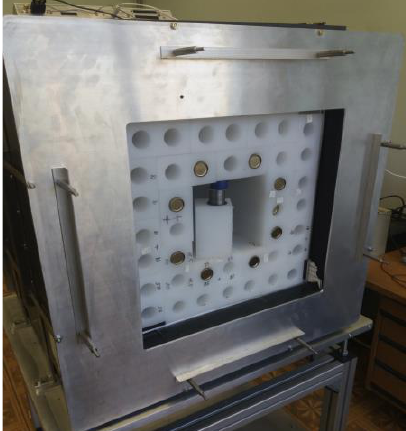
Fig. 2. Photo of neutron counters assembly with central channel for gamma- ray spectrometer. Nine neutron counters are placed in the inner layer of the polyethylene blocks for detection efficiency